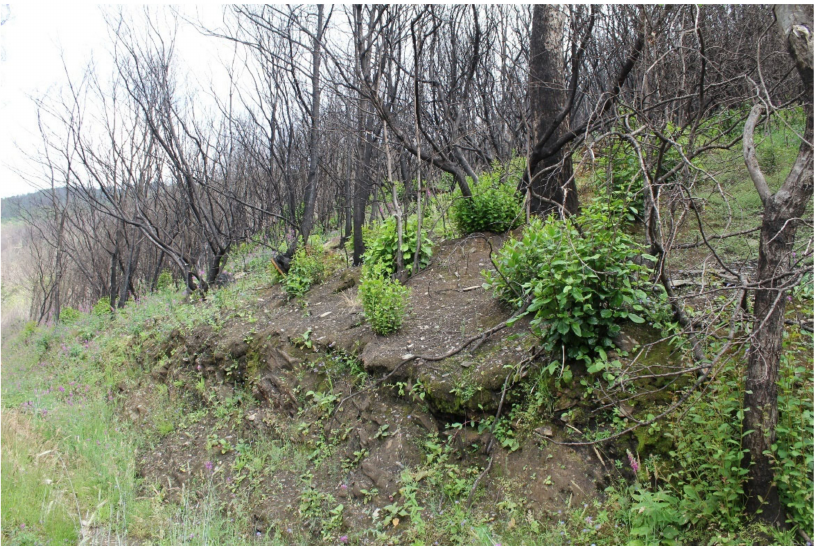
Figure 3. Vegetation regeneration nine months after a rural fire in Mata da Margaraça (Arganil, Portugal).